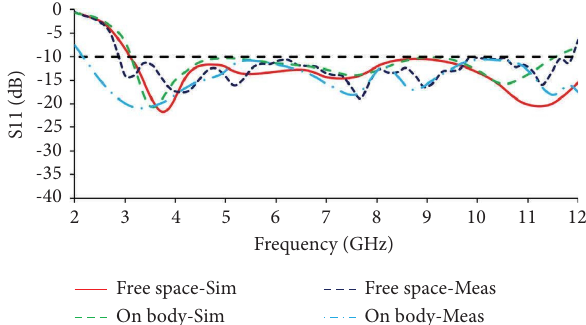
Figure 23: Refection coefcient plots of the MIMO antenna in free space and on the body. Table 2: Comparison of the proposed work with existing literature.